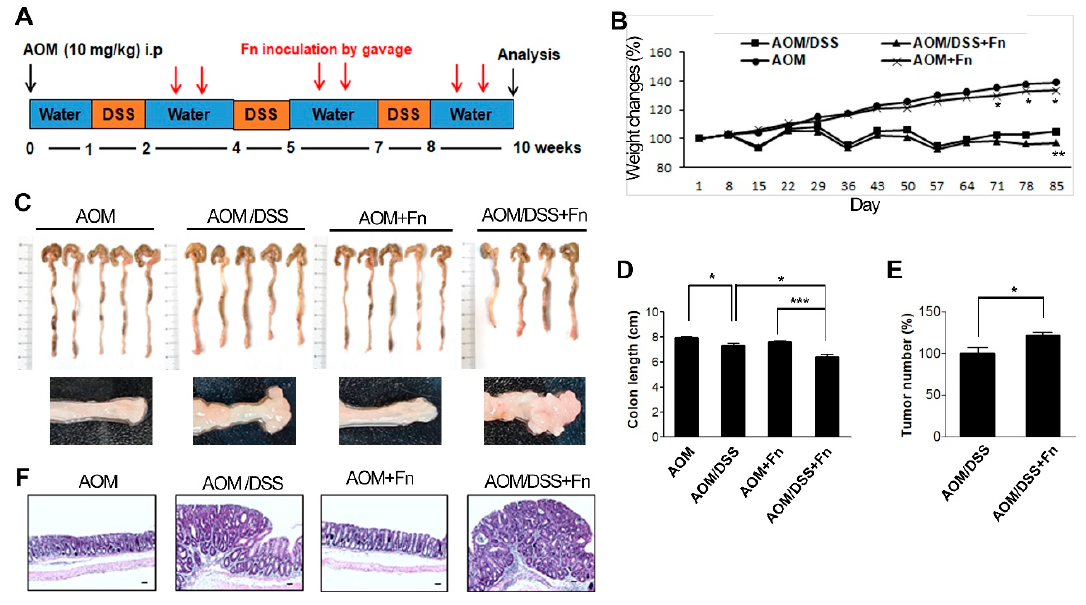
Figure 5. F. nucleatum accelerates the progression of CRC in AOM / DSS model mice. Tumors were induced in C57BL / 6 mice with AOM / DSS. ( A ) Experimental procedure for the establishment of the ulcerative colitis-related colorectal cancer model and treatment. Abbreviations: i.p. injection, intraperitoneal injection. ( B ) Body weight changes in mice were monitored at the indicated times after AOM injection. The data are presented as the mean ± SEM (* p < 0.05, and ** p < 0.01; unpaired Student’s t -test). ( C ) Representative morphological features of the whole colons from mice with or without F. nucleatum infection in the AOM / DSS model (upper panel). Lower panels are enlarged images. ( D ) Colon length was measured on day 85. The data are presented as the mean ± SEM (* p < 0.05 and *** p < 0.001; unpaired Student’s t -test). ( E ) The number of tumor nodules in colon tissue was counted on week 12. Data are presented as the average tumor number ± SEM ( n = 6). * p < 0.05 compared with the AOM / DSS group. ( F ) Representative hematoxylin and eosin-stained sections of the distal colon showing the morphology of AOM, AOM / DSS, AOM + F. nucleatum , or AOM / DSS + F. nucleatum -treated mice ( n = 5 per group). 100 times magnification; scale bar: 100 µ m. Abbreviations: AOM, azoxymethane; DSS, dextran sodium sulfate; Fn, F. nucleatum .